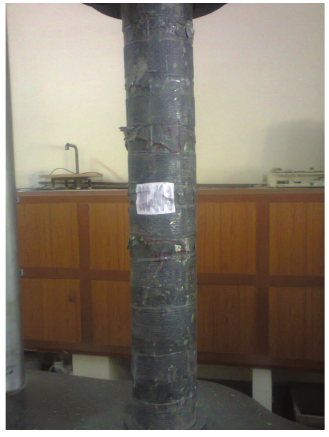
Figure 10: Failure pattern of